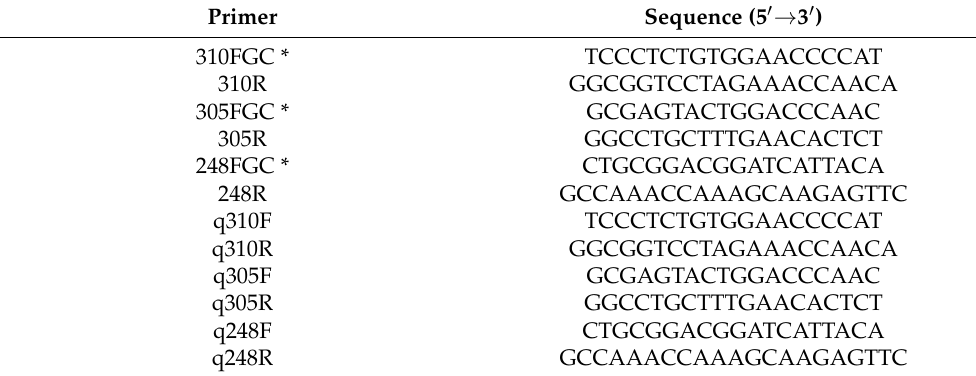
Table 1. Primers used for PCR or absolute quantitative real-time PCR in this study.